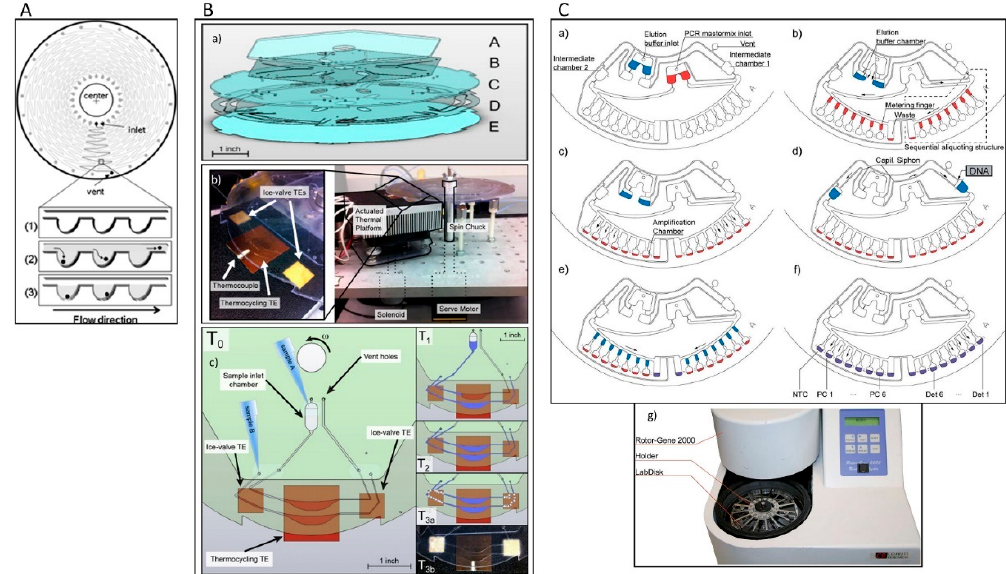
Figure 3. ( A ) Microfluidic design of a compact disc (CD) device and schematic illustration of single cell isolation: (1) a large number of microchambers align along a channel, (2) the cells flow through the microchambers and (3) are spread into individual microchambers [69]. ( B ) (a) Schematic graph of the multi-layered centrifugal disc. The disc is comprised of five layers of hard plastic: A. polycarbonate sheet, B. pressure sensitive adhesive tape (PSA), C. polycarbonate sheet, D. polycarbonate film, and E. polycarbonate film. (b) (Right) Image of the integrated centrifugal microfluidic platform for pumping, valving, and thermocycling of fluid. (Left) Close-up of the actuated thermal platform showing the location of the central thermocycling TE and two ice-valve TEs. (c) Schematic presentation of the hardware details and fluidic process for the integrated CD system [70]. ( C ) Schematic illustration of one microfluidic structure: (a) elution bu ff er and PCR mastermix are loaded to the inlets, (b) the elution bu ff er is transported into two elution bu ff er chambers while the PCR mastermix is distributed into metering fingers, (c) the PCR mastermix aliquots are gated into amplification chambers which filled with primers, (d) DNA is added to one of the sub-volumes, (e) each subvolume is aliquoted into several aliquots, (f) PCR is started, and (g) the Lab Disk is mounted to a custom-made holder [71]. Reproduced from the mentioned references with permission from the related journals.